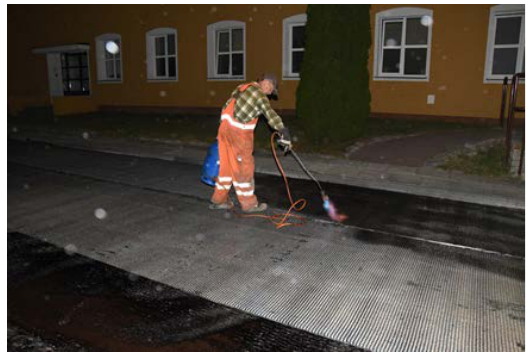
Figure 9. Milled surface of the binder course. Materials 2017 , 10 , x FOR PEER REVIEW